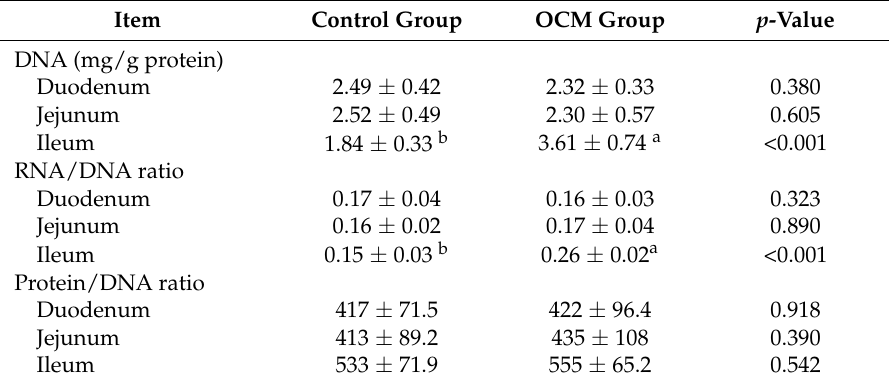
Table 4. Effects of dietary supplementation with OCM (50 mg/kg diet) on DNA levels and RNA/DNA and protein/DNA ratios in the intestine of